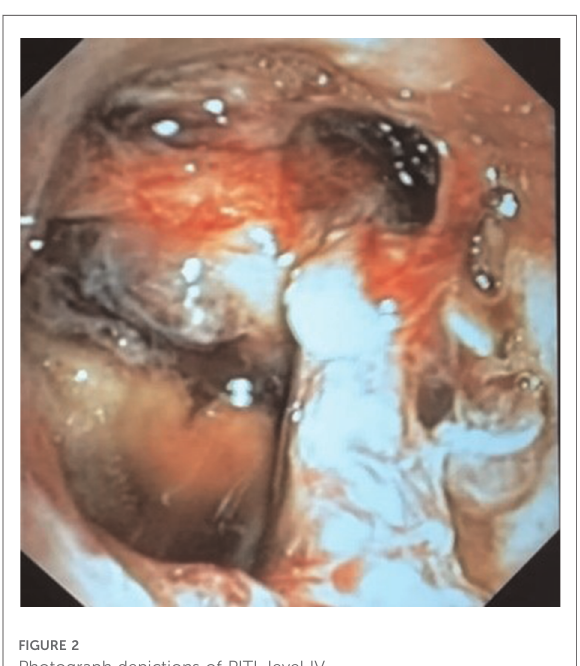
FIGURE 2 Photograph depictions of PITL level